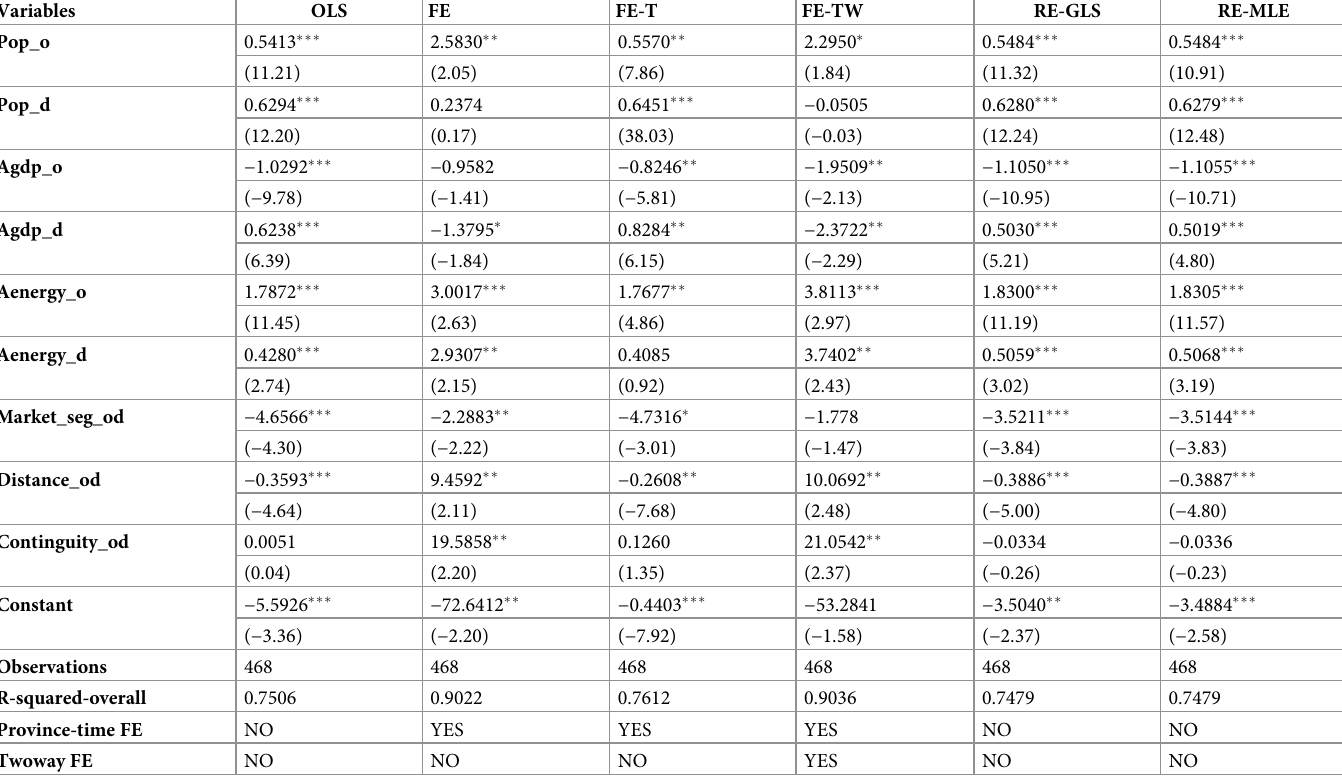
Table 2. The gravity estimated results using interprovincial embodied CO 2 flows within Eastern China.